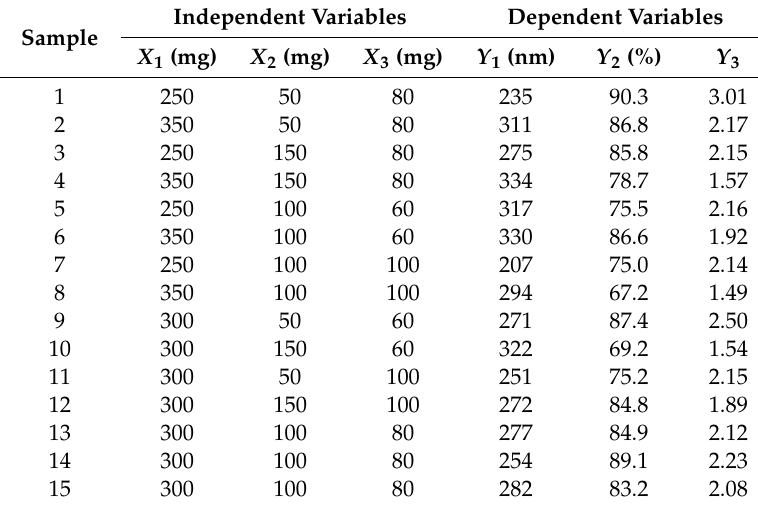
Table 2. Observed responses in Box–Behnken design for rifapentine (RPT)-loaded nanostructured lipid carriers